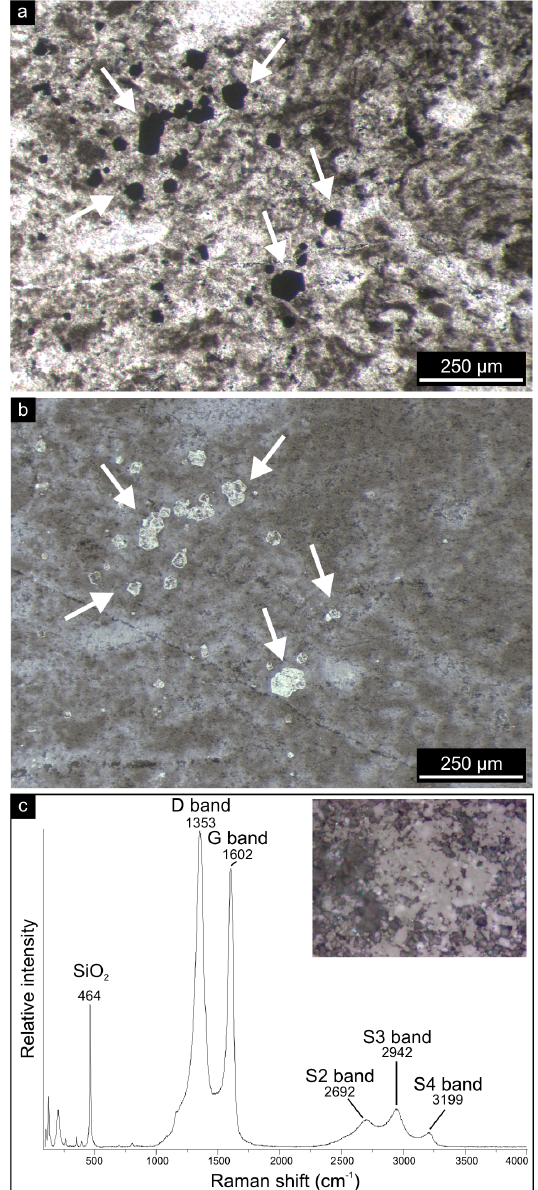
Figure 2. Petrographic observations on the hydrothermal chert vein. (a, b) Thin section photographs ( a transmitted light; b reflected light) showing kerogen (brownish colours) and pyrite (arrows, black colours in a , bright colours in b ) embedded within a fine-grained chert matrix. Note that the pyrite crystals (arrows) are excellently preserved and show no evidence of oxidation. (c) Representative Raman spectrum of kerogen (D band at 1353cm − 1 and G band at 1602cm − 1 ) present in the hydrothermal chert vein. Note the wide D and G bands (82 and 55cm − 1 width, respectively), pointing to ther- mally mature and structurally disordered kerogen, and the absence of an S1 band (at 2450cm − 1 ), consistent with prehnite–pumpellyite to lower greenschist metamorphosis and a temperature of ca. 300 ◦ C (cf. Yui et al., 1996; Delarue et al.,